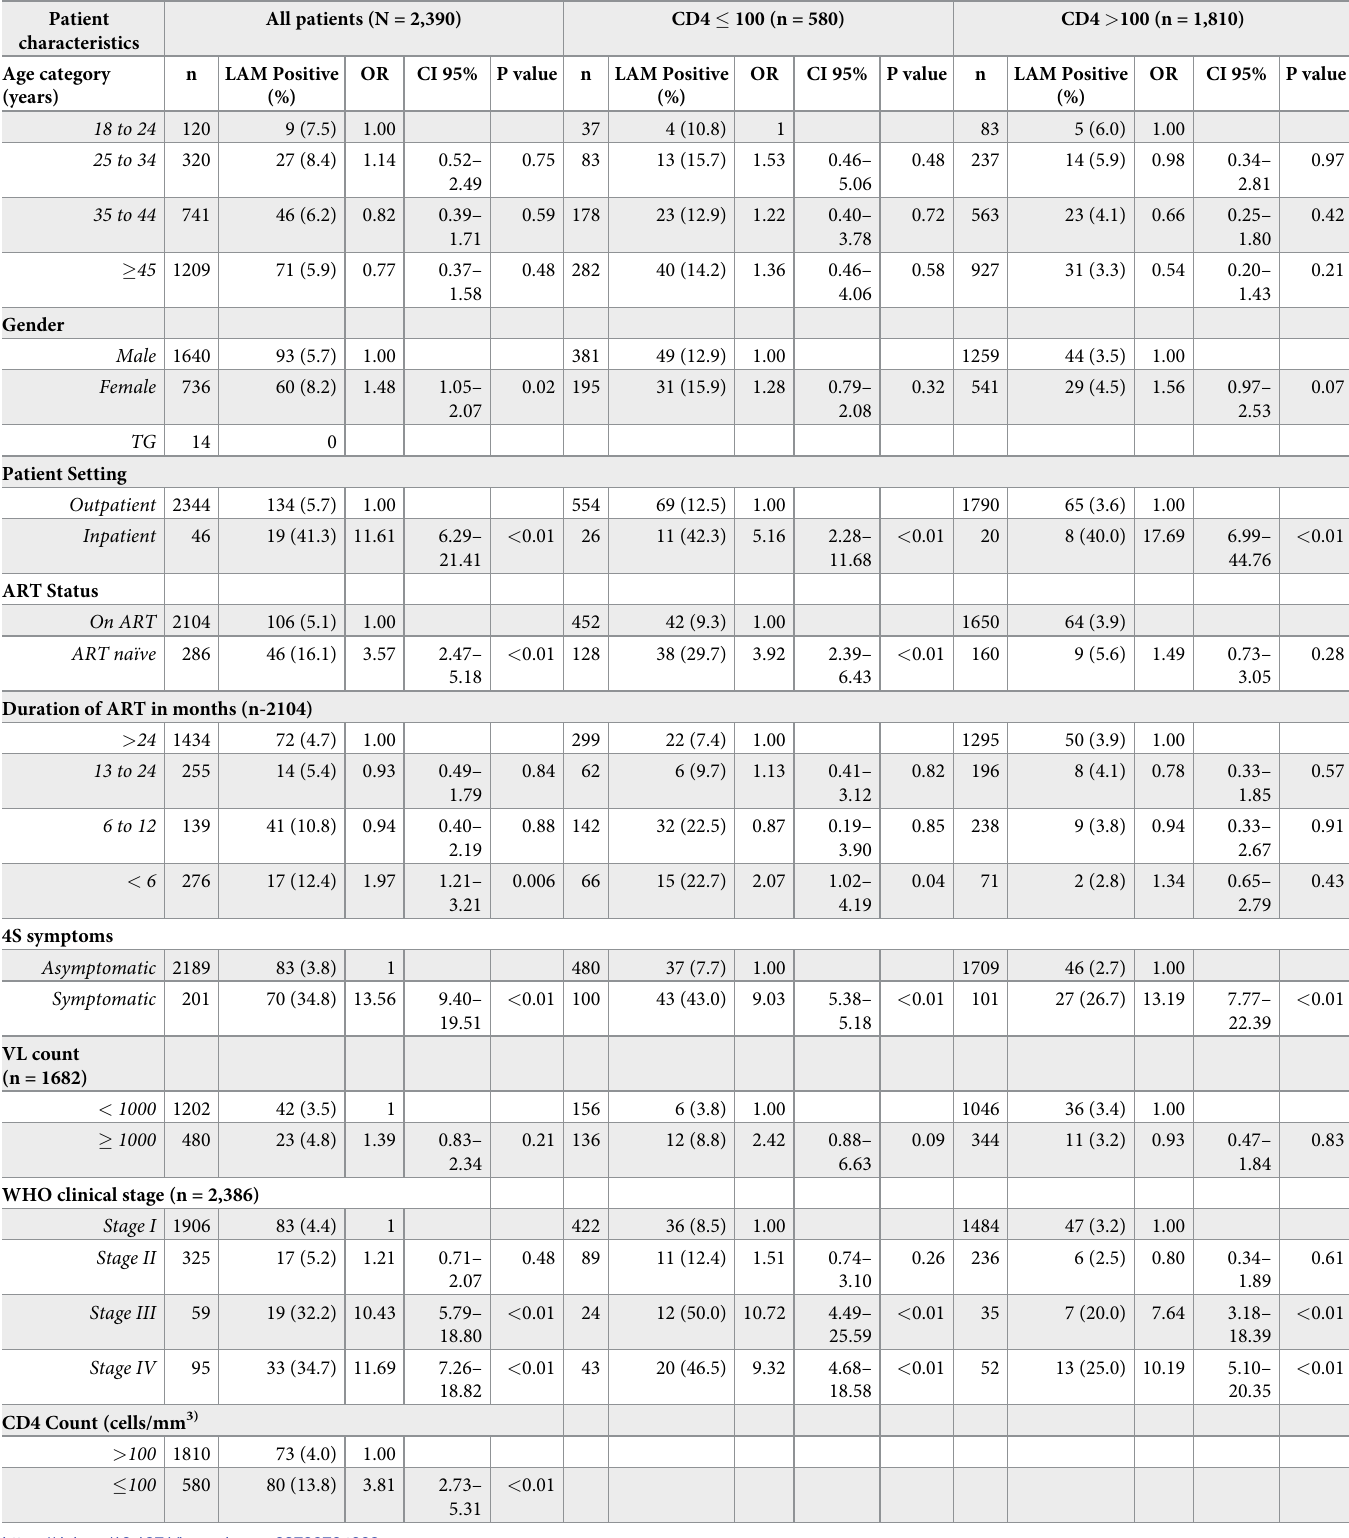
Table 3. Association of demographic and clinical factors with urine LF- LAM positivity–Univariate analysis. Patient